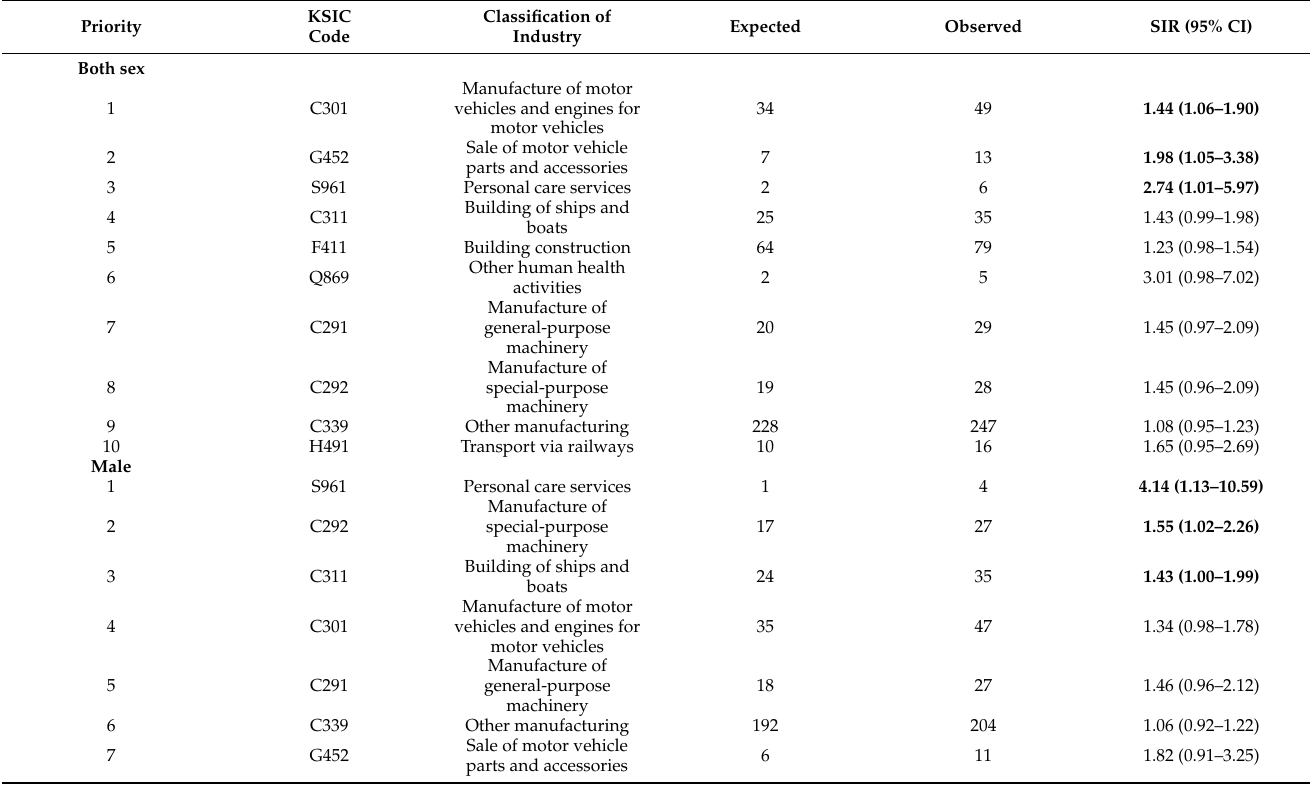
Table 3. Top 10 priority KSIC groups with a high risk of leukemia as assessed by age-standardized incidence ratios (SIRs) and a 95% confidence interval (95%